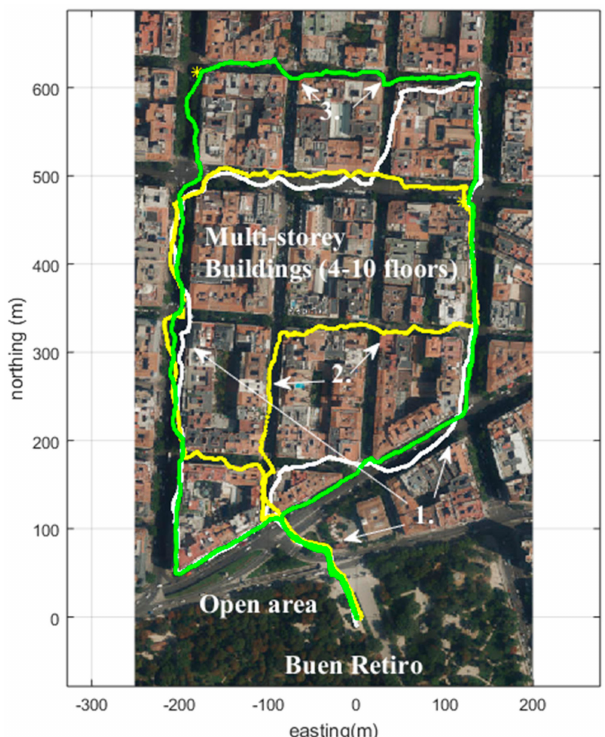
Figure 2. The green GNSS track was recorded 11:30 on 29th of August, 2018 using Samsung Galaxy S4 (GPS and GLONASS). The white track was recorded at 12:00. The yellow track was recorded at 12:30. Open area shows error below 4 m (1.). In the urban area in Madrid, with buildings, the error is greater (2.). In crossings the trail is affected